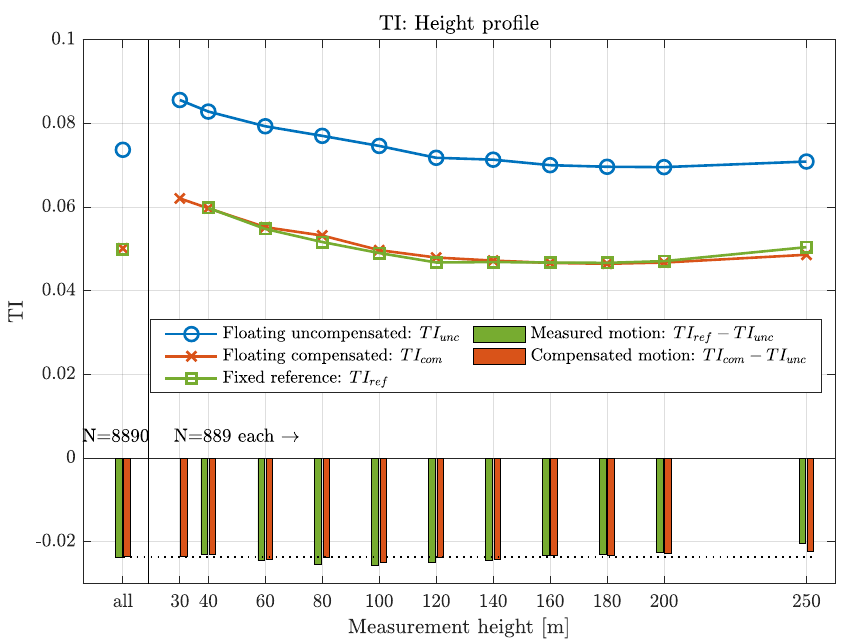
Figure 8. Average TI for all measurements and sorted by measurement heights. Blue circle markers indicate TI based on uncompensated measurements from the floating lidar. Red cross markers show corresponding values with motion compensation. Green square markers stand for values from the land-based fixed reference lidar for comparison. Bar plots show the motion-induced TI as the difference between measurements with the floating lidar and the fixed lidar (green) compared to the amount of motion-induced TI detected by the algorithm (red). The number of available measurement values at each height is